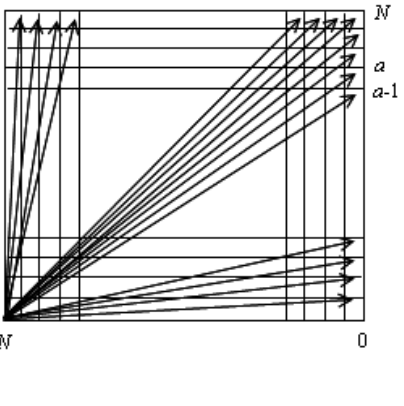
Figure 6. Representative angles in the image of N N × pixel format.